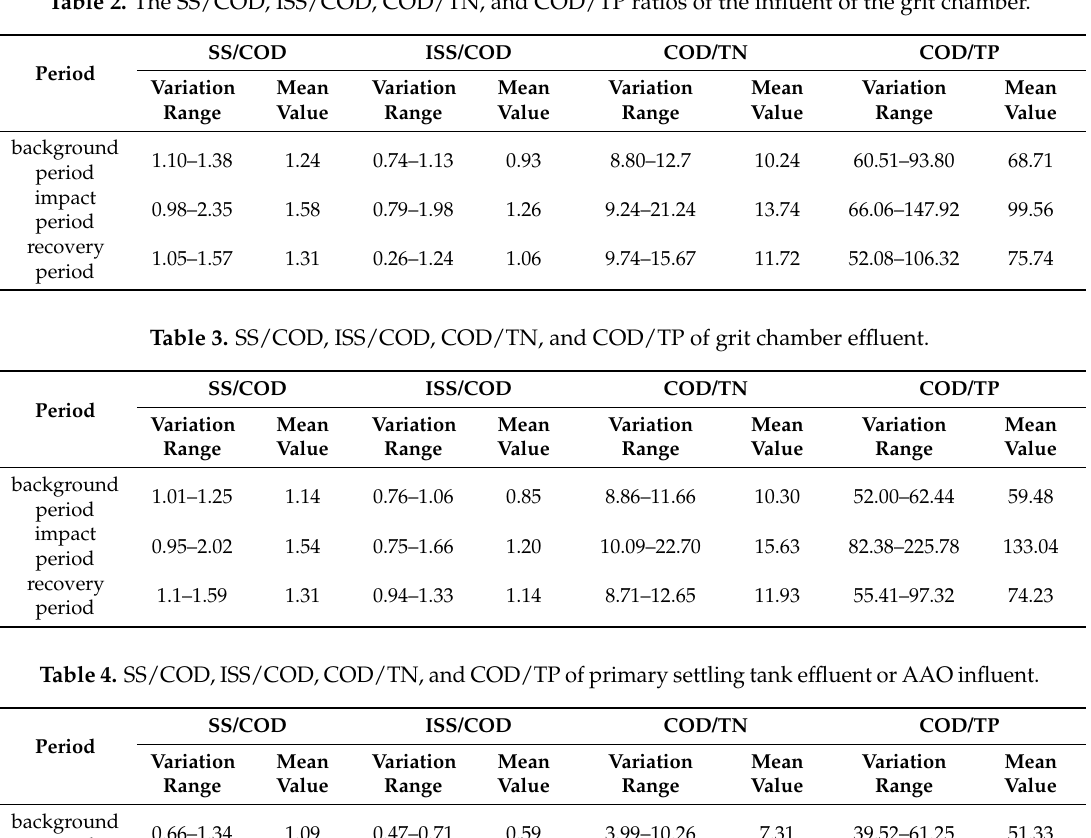
Table 2. The SS/COD, ISS/COD, COD/TN, and COD/TP ratios of the influent of the grit chamber.